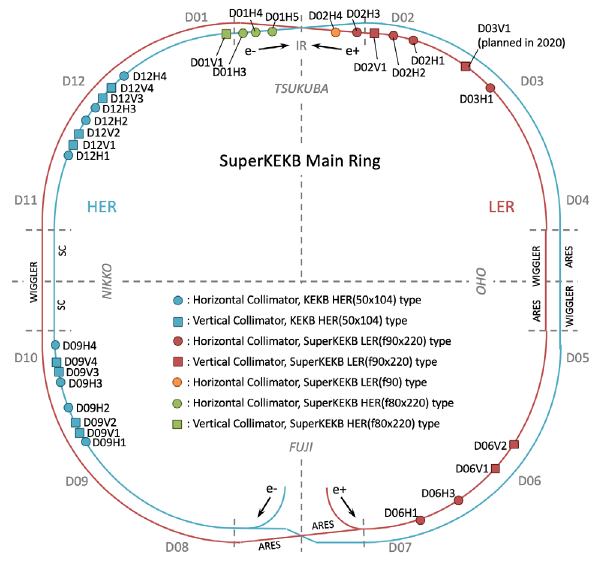
FIG. 2. Location of collimators in the SuperKEKB main ring. H and V in the collimator names refer to the horizontal and vertical